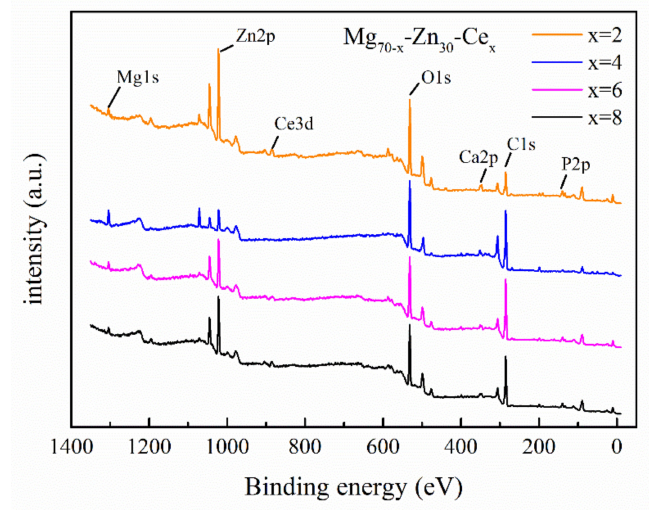
Figure 10. XPS spectra of the Mg 70 − x Zn 30 Ce x (x = 2, 4, 6 and 8) amorphous alloy ribbons after corrosion.